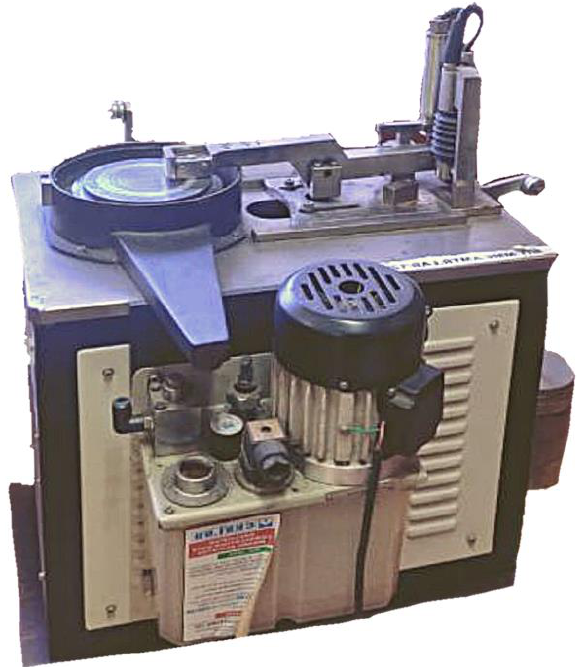
Figure 6. Experimental setup of pin-on-disc wear tester. Table 3. Selected levels and factors (TDOE). Table 4. Selected levels and factors (RSM).